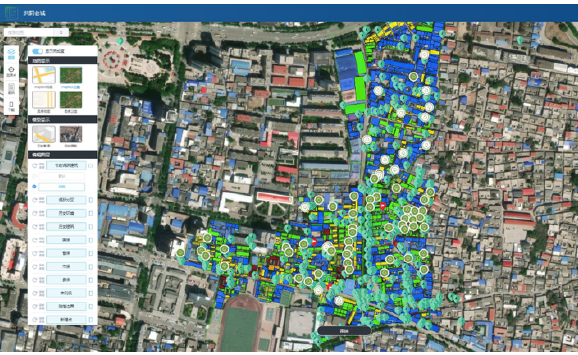
Figure 16 . Collection Results of Hongtong Traditional Districts.